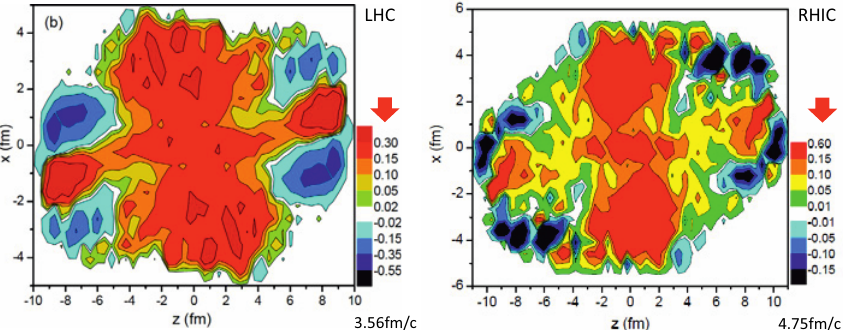
Figure 5. The thermal vorticity of the matter arising from a fluid dynamical calculation for two di ff erent beam energies. The thermal vorticity is inversely proportional with the temperature, which is increasing faster than the local vorticity with increasing beam energy. Thus the thermal vorticity at RHIC is larger. Also the side regions are cooler and this also increases the thermal vorticity, which enhances the polarization in due to equipartition. Based on ref.